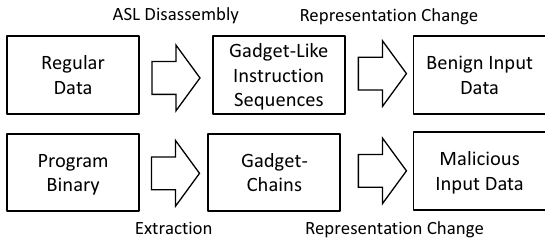
Fig. 3 The flow diagram for the data preparation process in